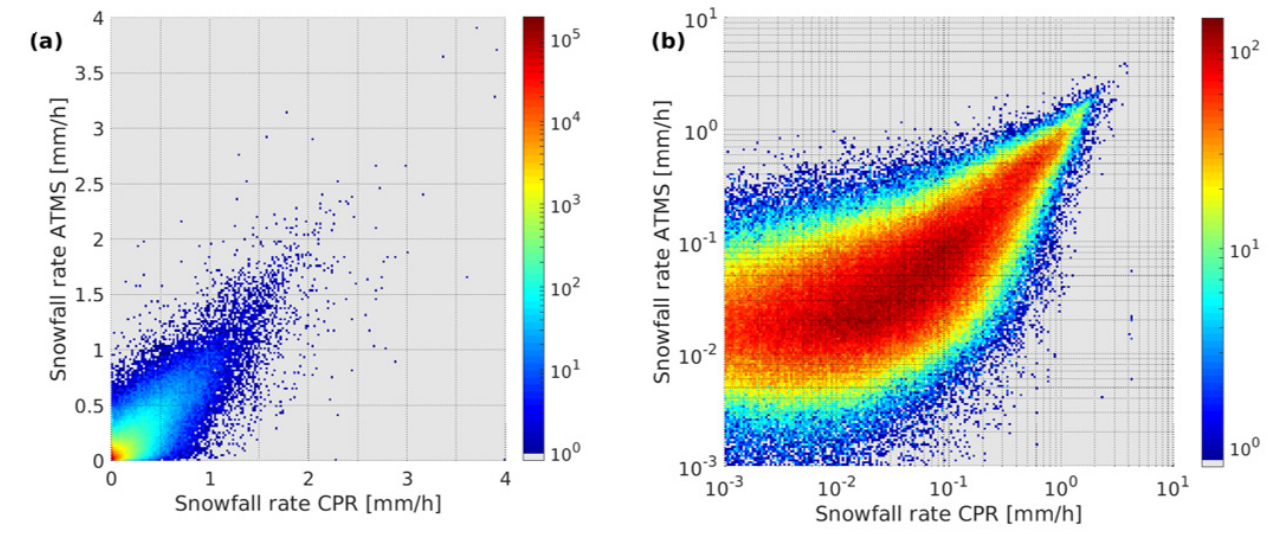
Figure 7. Snowfall rate estimate scatterplot. Both panels show density scatterplots, on linear ( a ) and logarithmic ( b ) scales.